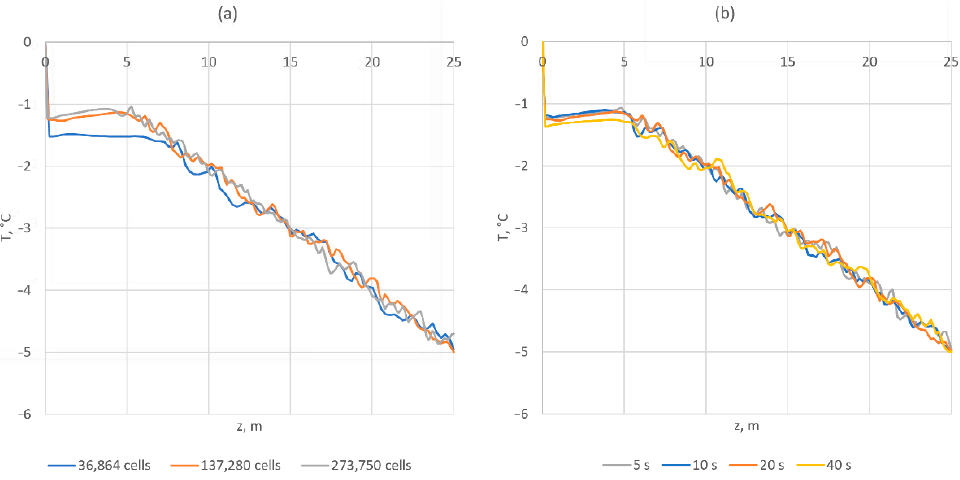
Figure 4. Temperature distributions along the borehole axis for different spatial meshes ( a ) and at different time steps ( b ).